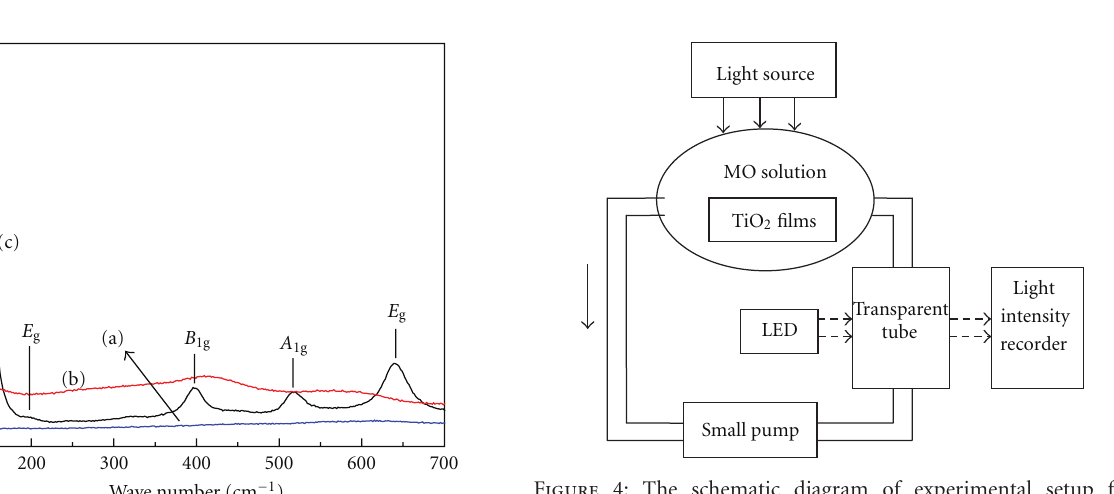
from the film surface [31]. MO was almost photodegraded completely using visible light after 4 hours.